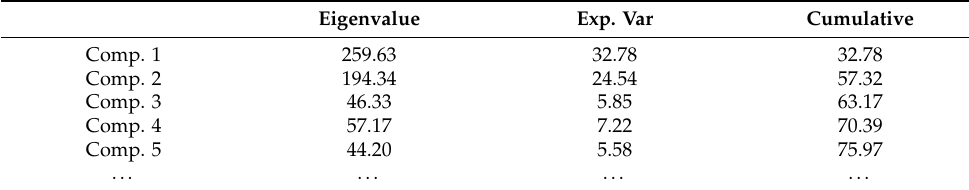
Table 2. Variance of the predictors explained in reduced dimension.